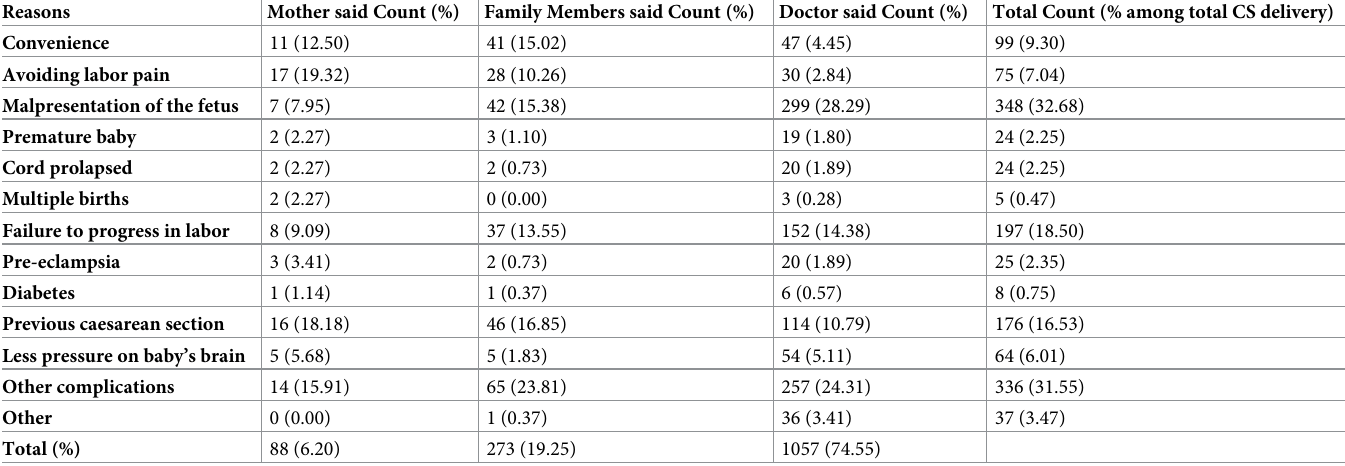
Table 2. Reasons for choosing caesarian section for delivery by decision makers based on the information reported by mothers (N = 1065).